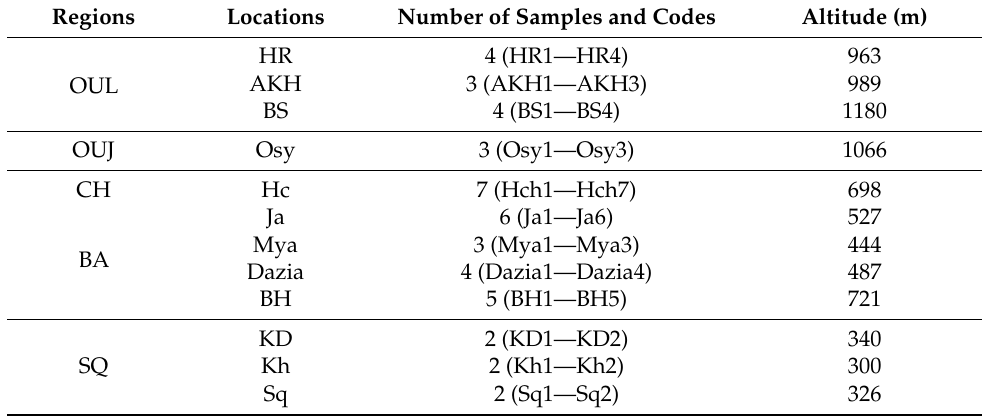
Figure 1. Sampling points and geographic origin of the A. unedo surveyed populations. Table 1. Number of samples and altitude of the 12th locations prospected.